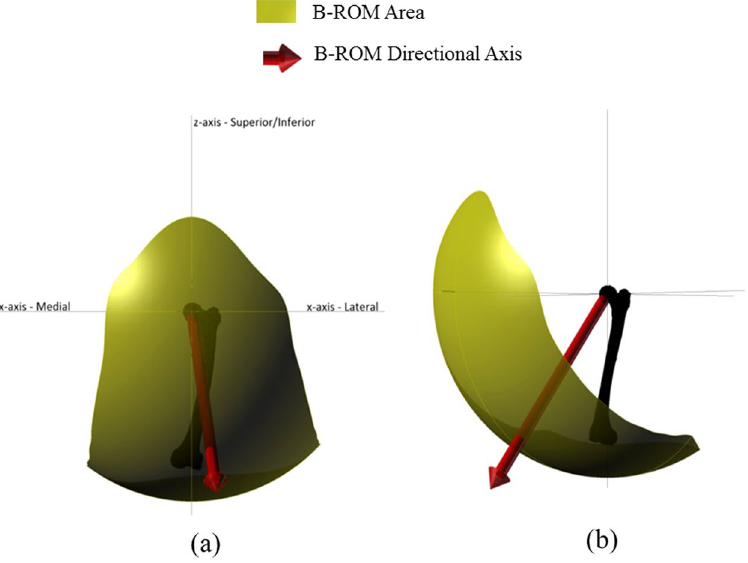
Figure 2. Representation of the ROM benchmark area and corresponding directional axis of ROM area. ( a ) Coronal view, ( b ) Sagittal